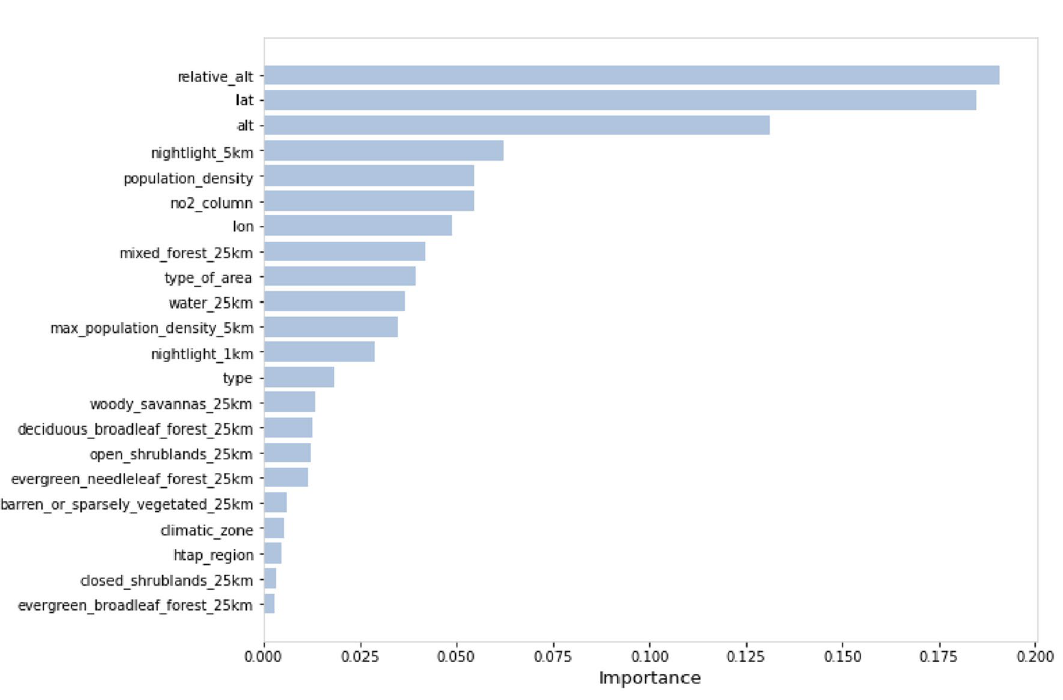
Figure 6. Feature importance in random